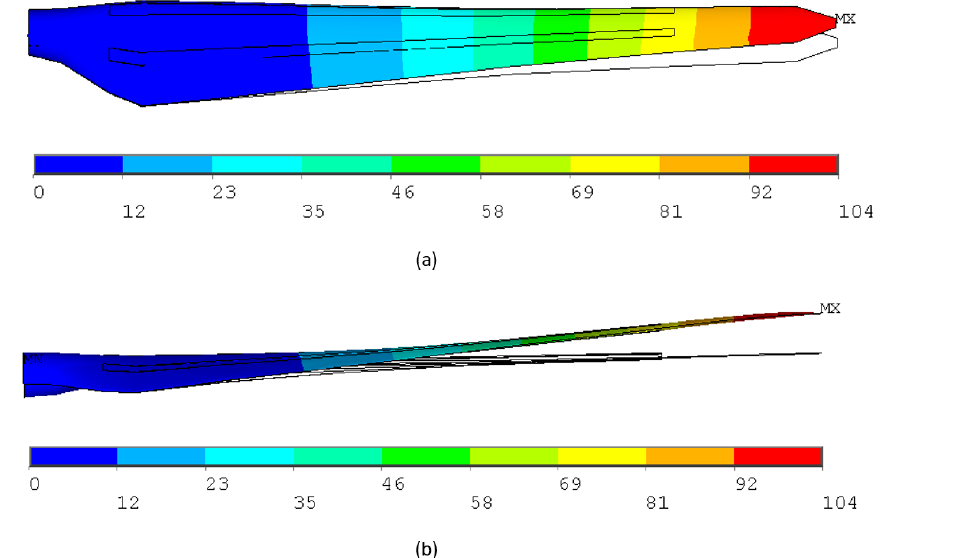
Figure 24. Total deformation of the RÜZGEM blade model vs. undeformed model under 100% combined extreme edgewise and extreme flapwise loading condition (a) top view and (b) side view (scale factor: × 2 .